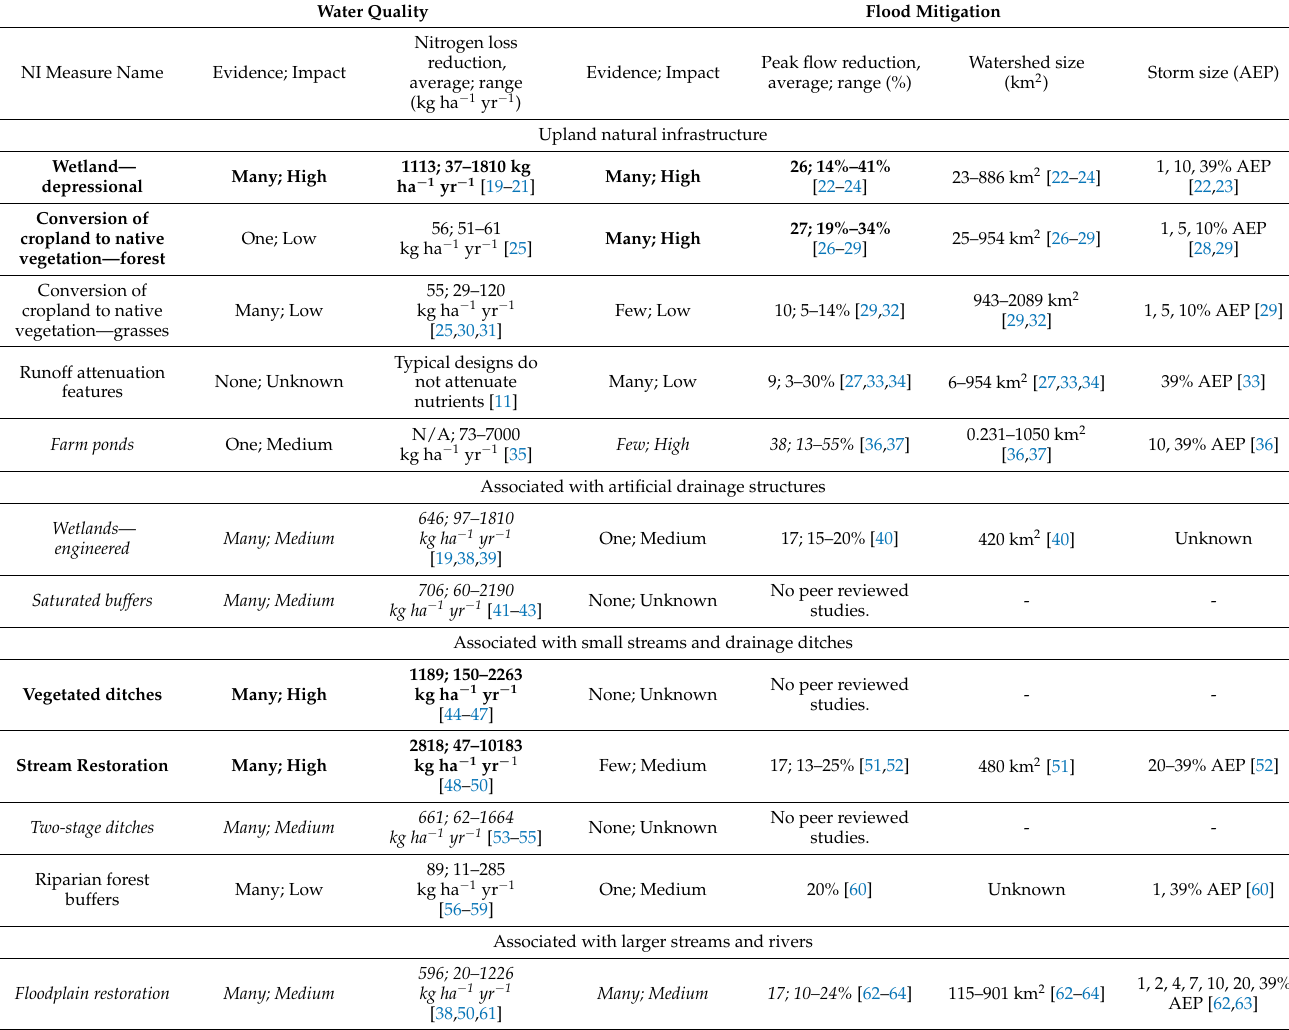
Table 4. Natural infrastructure measures: Evidence for and impact assessment of nutrient loss reduction (water quality) and flood mitigation from specific studies, noted by the references in square brackets. Evidence is characterized as None, One, Few (2), or Many (3 or more) peer-reviewed publications. Impact is characterized as Unknown, Low, Medium, or High. The values for nitrogen reduction are set at Low for <500 kg ha − 1 yr − 1 , Medium for 500–1000 kg ha − 1 yr − 1 , and High for more than 1000 kg ha − 1 yr − 1 . We categorized peak flow reductions as Low for <15%, Medium for 15%–25%, and High for values over 25%. Measures that we would consider to be “High” priorities for implementation (as shown in Figure 1), with Many publications reporting High impacts, are shown in bold ( Many; High ); measures that we consider to be “Medium” priorities for implementation (as shown in Figure 1) are shown in italics ( Many; Medium or Few; High ). More detailed tables for water quality and flood mitigation natural infrastructure measures are included in the Supplementary